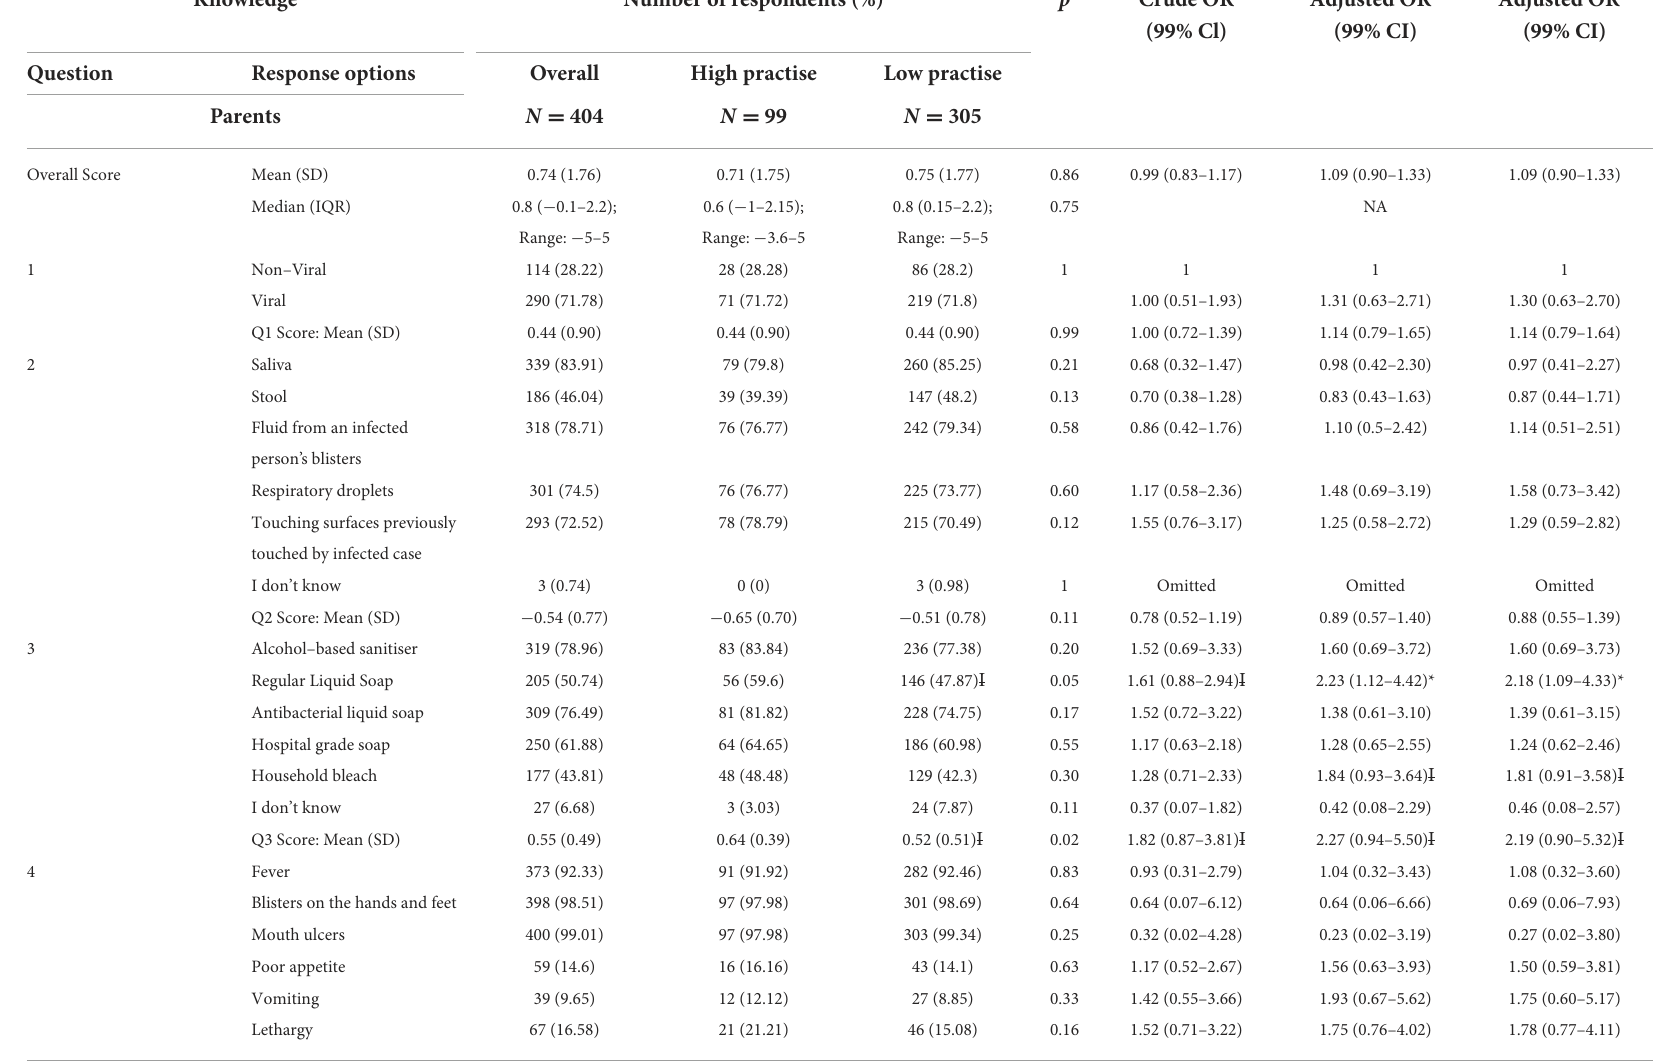
TABLE 4 Knowledge of parents and teachers towards